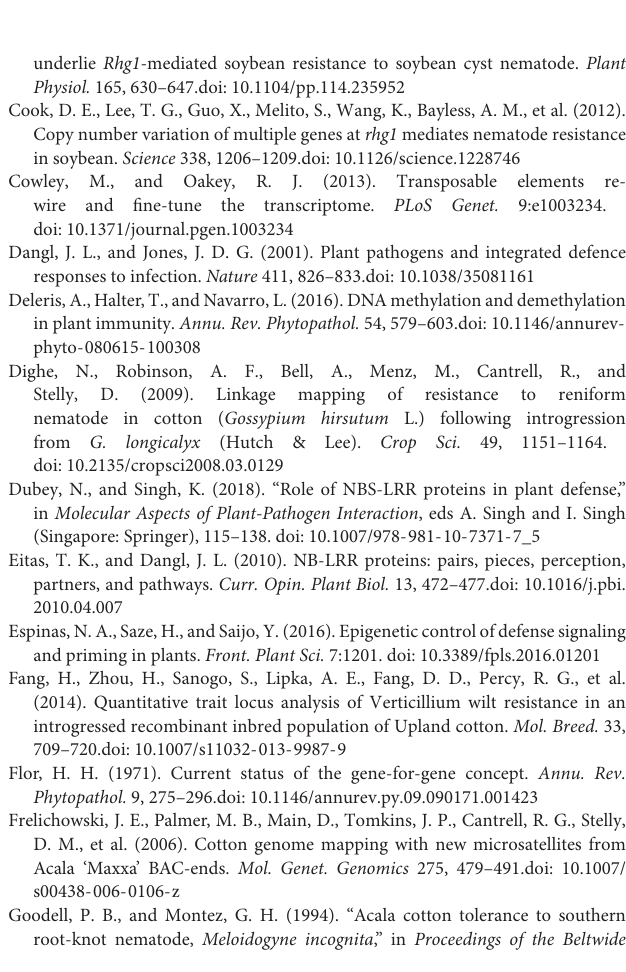
Supplementary Figure 2 | Comparison of (CC)-NB-LRR protein of Chr11-UCR91- EVM0000068.1 with RGA4 ( Gossypium arboreum , XP_017630309.1) and RGA2-like isoform X1 ( Gossypium raimondii , XP_012435026.1) in cotton. Supplementary Figure 3 | Comparison of (CC)-NB-LRR protein of Chr11-UCR316-EVM0000014.1 with RGA2-like isoform X1 ( Gossypium raimondii , XP_012435026.1) in cotton. Supplementary Figure 4 | Comparison of (TIR)-NB-LRR protein of Chr11-NAU2152-EVM0000122.1 with TMV resistance protein N-like in cotton. The sequence in light blue in the first line represents CC domain, NB-ARC domain in yellow, and LRR domains in green and gray. Supplementary Figure 5 | The evolutionary tree of amino acid sequences of R genes on Chr 11 and Chr 21. Supplementary Figure 6 | Comparison of CCAAT-binding transcription factor (CBF-B/NF-YA) subunit B in the rkn1 region between Chr 11-CIR316 and Chr 21-CIR316. Supplementary Figure 7 | Comparison of SRF-type transcription factor (DNA-binding and dimerisation domain) in the rkn1 region between Chr 11-CIR316 and Chr 21-CIR316-UCR56. Supplementary Figure 8 | Comparison of protein kinase domain in the rkn1 region between Chr 11-BNL2650 and Chr 21- BNL2650.